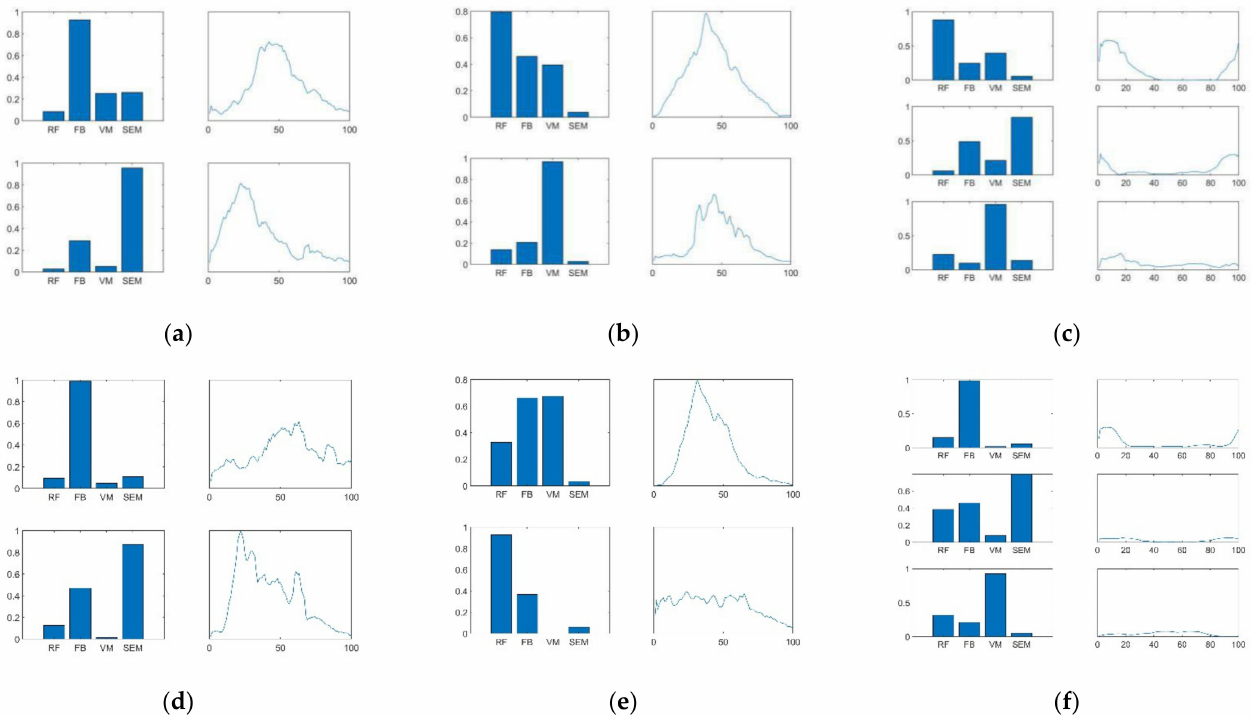
Figure 5. Typical examples of the muscle synergy pattern and the corresponding activation coefficient with the optimal number of muscle synergies in CG (subject No.10, denote as CG10) and SG (subject No.11, denote as SG11). The muscle synergy and its corresponding activation coefficient of each subgraph from top to bottom is arranged from large to small according to its activation ratio described in Section 3.4.2. ( a ) The STD of CG10, ( b ) the ST of CG10, ( c ) the Gait of CG10, ( d ) the STD of SG11, ( e ) the ST of SG11, ( f ) the Gait of